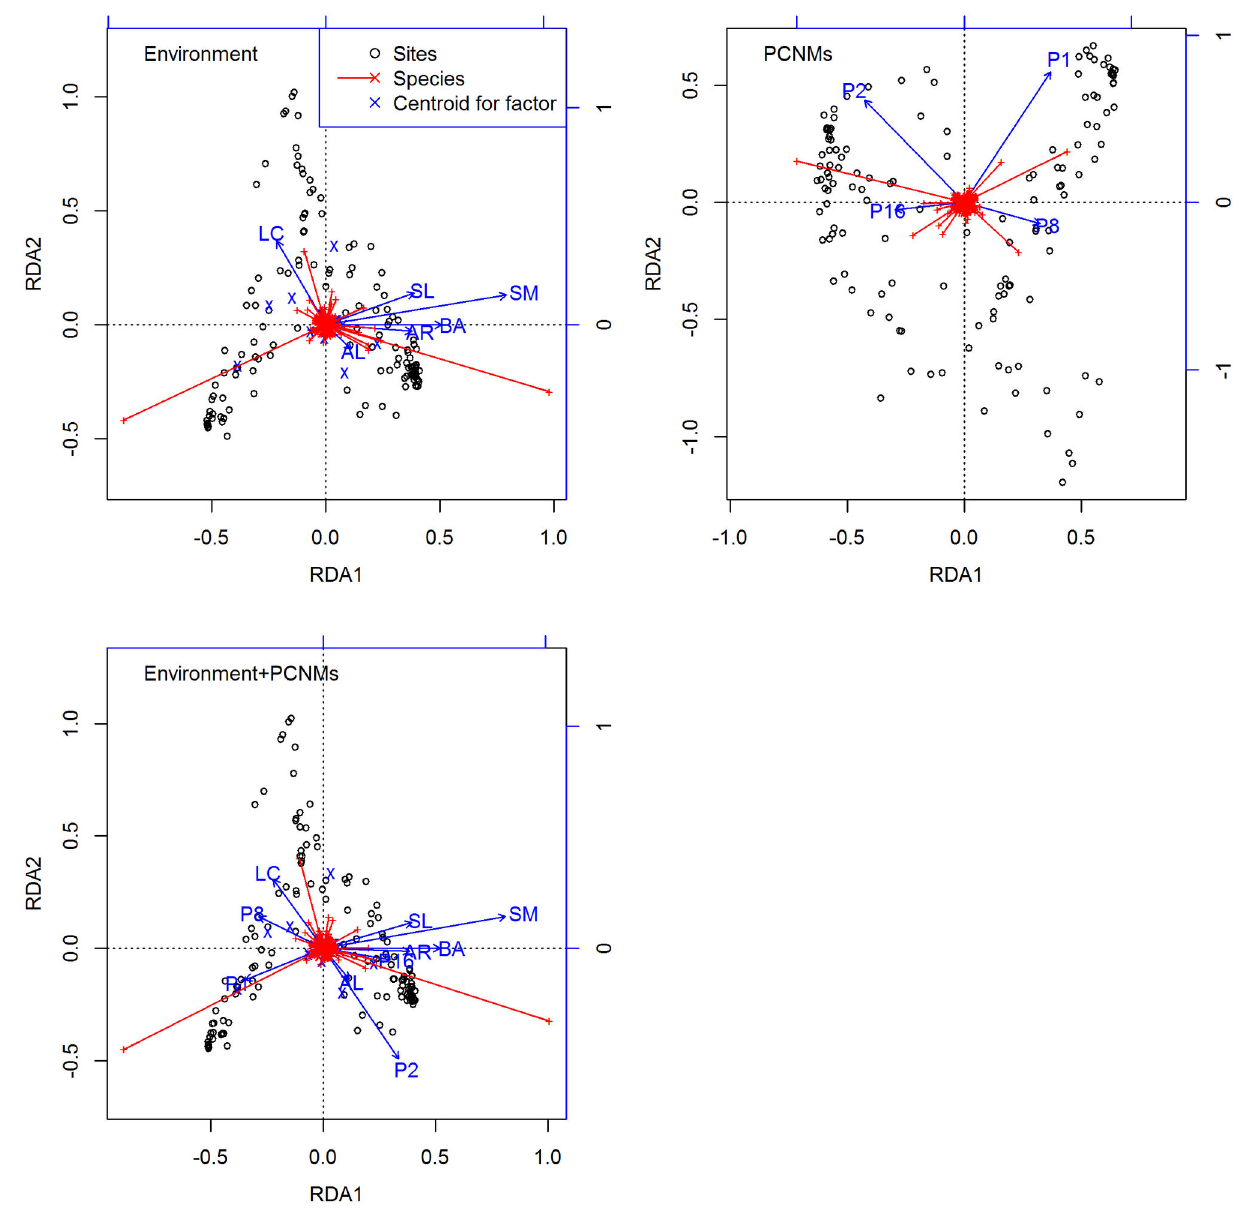
Figure 5. RDA tri-plots of the species composition data constrained by the selected environmental variables and PCNMs, scaling 2. Abbreviations: AL (altitude), AR (annual rainfall), BA (basal area of trees per square meter), LC (litter coverage), SL (slope), SM (soil moisture). The bottom and left-hand scales are for the objects and the response variables, the top and right-hand scales are for the explanatory